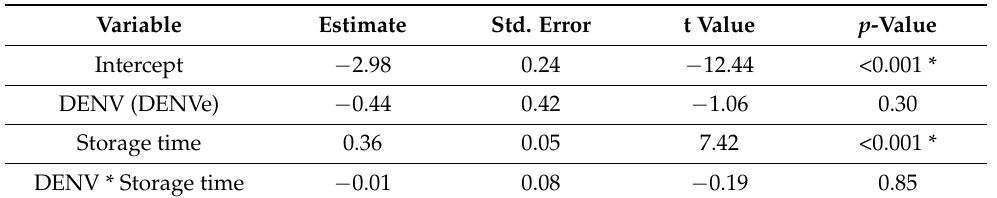
Table 5. Linear regression for the effect of maternal DENV exposure and egg storage time on Wolbachia density in adult females.